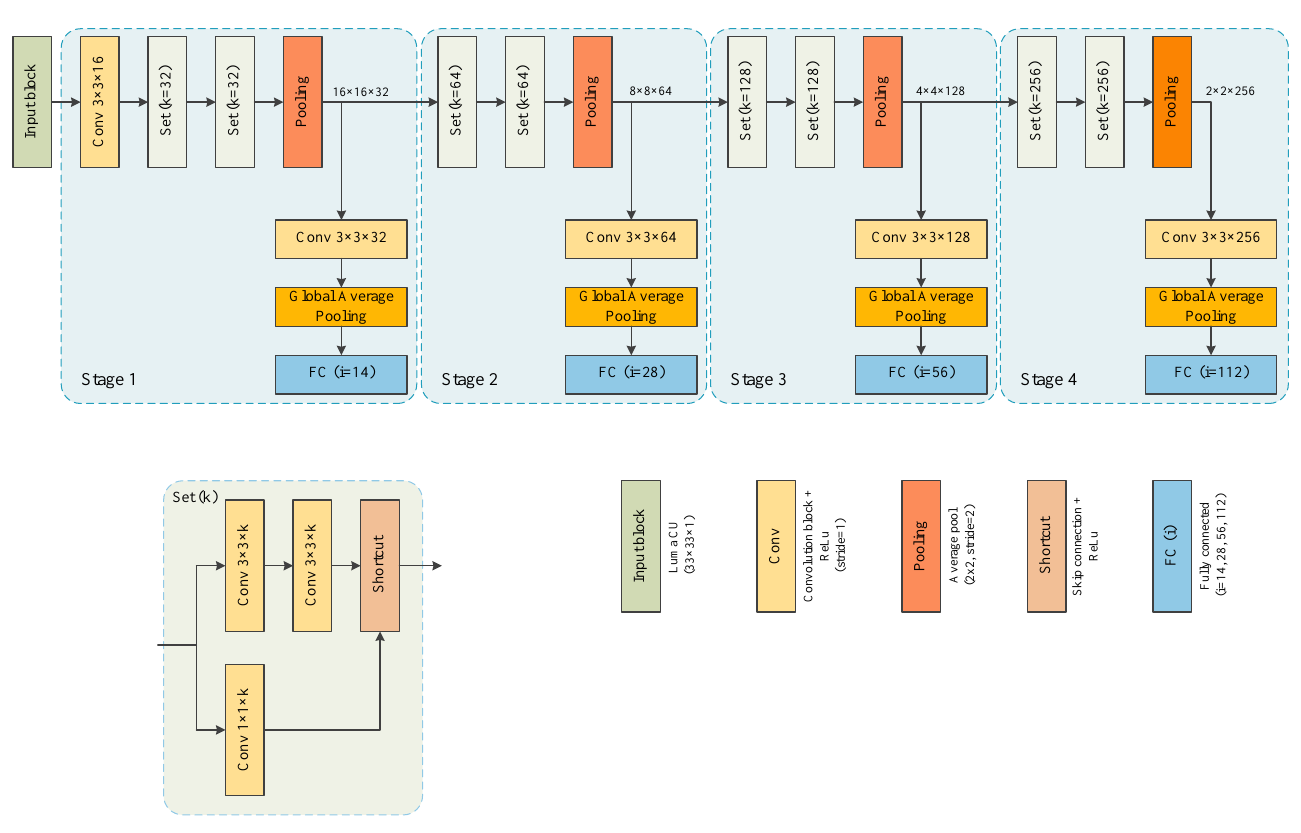
Figure 4. Structure diagram of the proposed MET-CNN model.